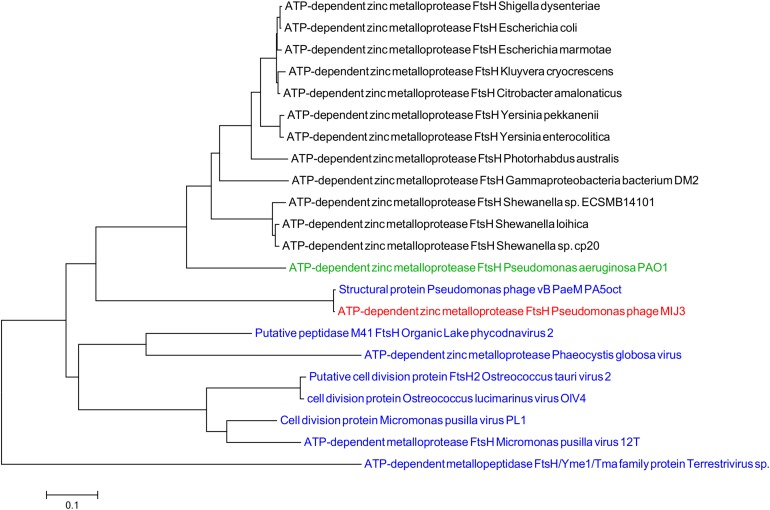
Phylogenetic tree of FtsH based on the amino acid sequence of phage MIJ3 and the most similar sequences in the database. It shows the FtsH of MIJ3 (red), the most similar amino acid sequences in viruses (blue), and bacteria (black) including P. aeruginosa PAOI, the bacterial host of MIJ3 (green).